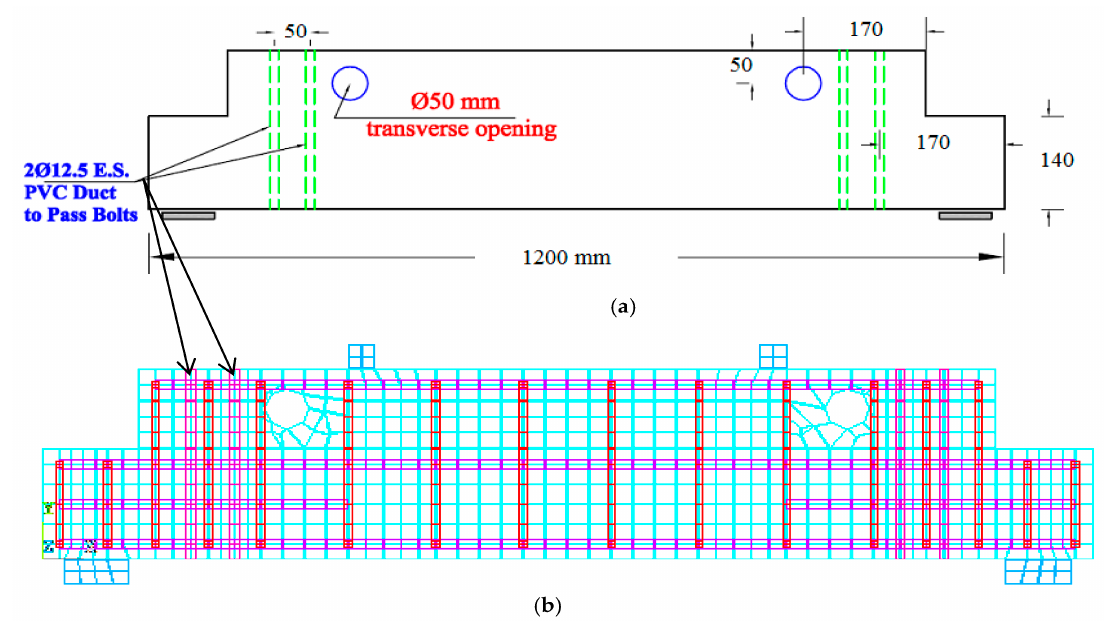
Figure 7. Experimental details and numerical simulations of model DET6. ( a ) Geometry layout in the previous experimental investigation [39]. ( b ) Numerical modelling.